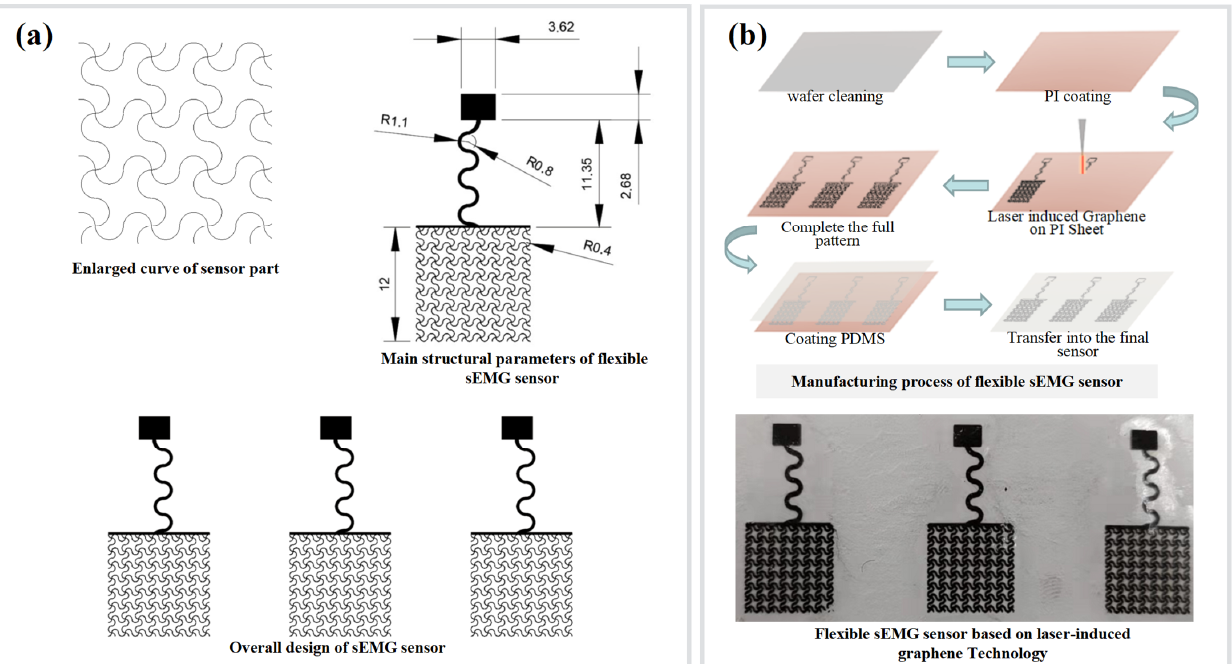
Figure 1. Process of flexible stretchable myoelectric sensor preparation. ( a ) The process of designing the lead transmission line part of the sensor using flexible serpentine and the sensor acquisition interface part. ( b ) The manufacturing process of a flexible sEMG sensor.